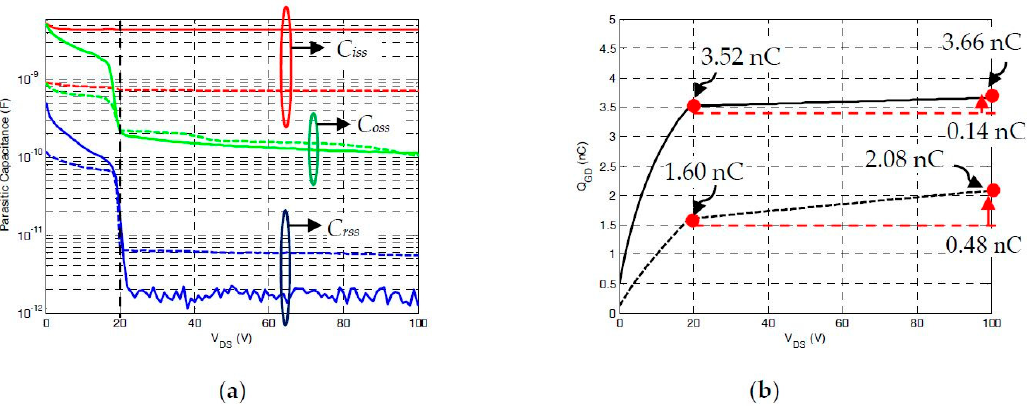
Figure 13. Comparison of fabricated and commercial GaN FETs [TPH3006PS] regarding ( a ) capacitances and ( b ) Q GD charges. (Dashed line: commercial GaN FETs, solid line: fabricated GaN FET). Table 4. Comparison of the parasitic capacitances and charges between the commercial and fabricated GaN FETs [TPH3006PS].